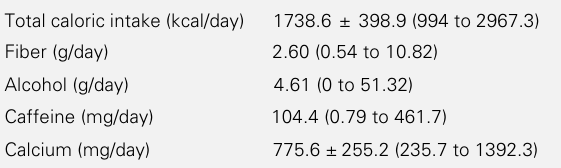
Table 2 - Relevant data obtained from a 4-day dietary inquiry of premenopausal women who participated in the study. Data are reported as means ± SD (range) or as median (range) for 60